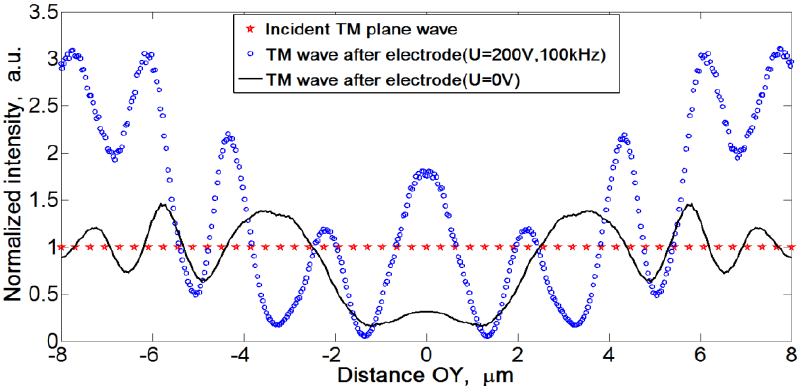
Figure 23. Normalized intensities of incident TM plane wave before the central electrode (red stars), TM wave behind the central electrode with the electric field-induced variation of the extraordinary refractive index (empty blue dots), and TM wave behind the central electrode when the electric field is switched off (solid black line). In the center of shadow, near OY = 0, the light intensity in the “field on” case is higher than in the “field off”